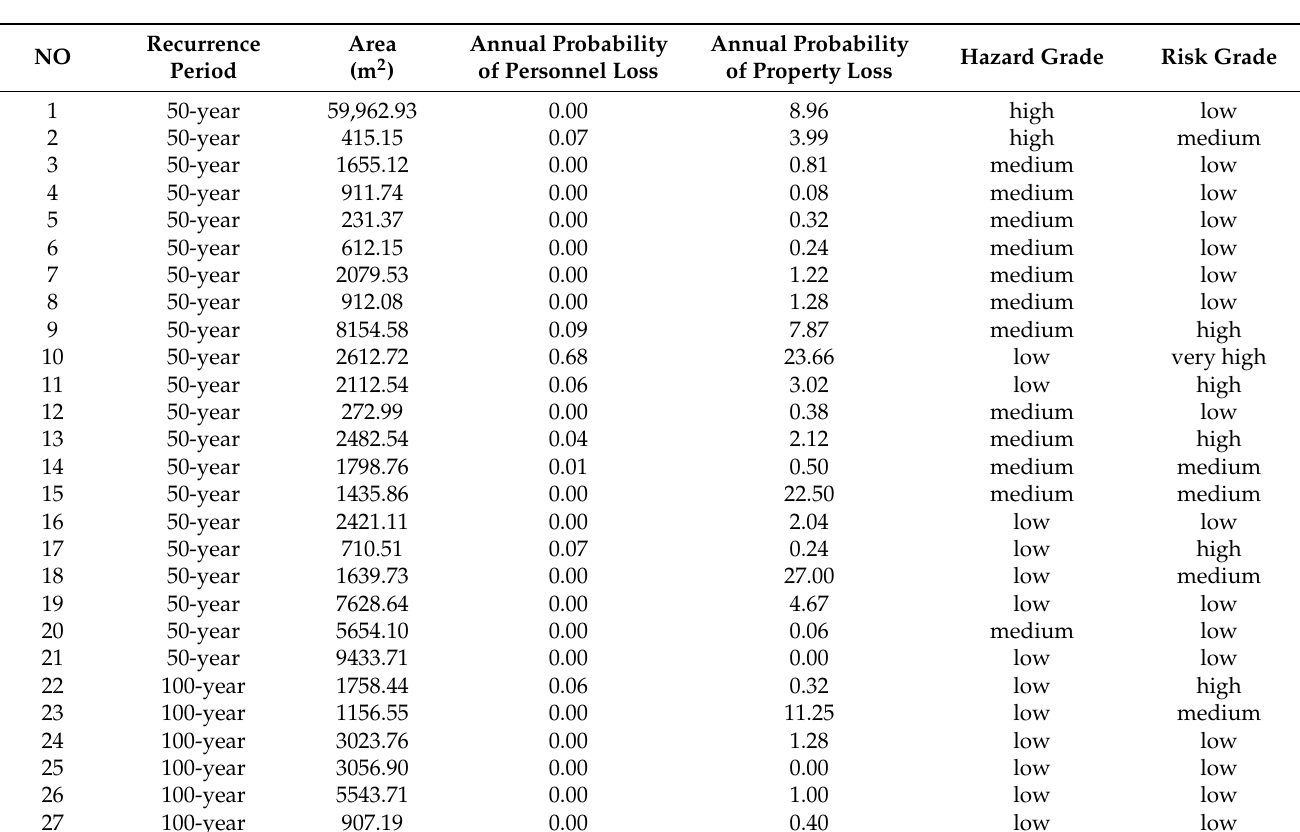
Table 10. Hazard grade and risk grade of all